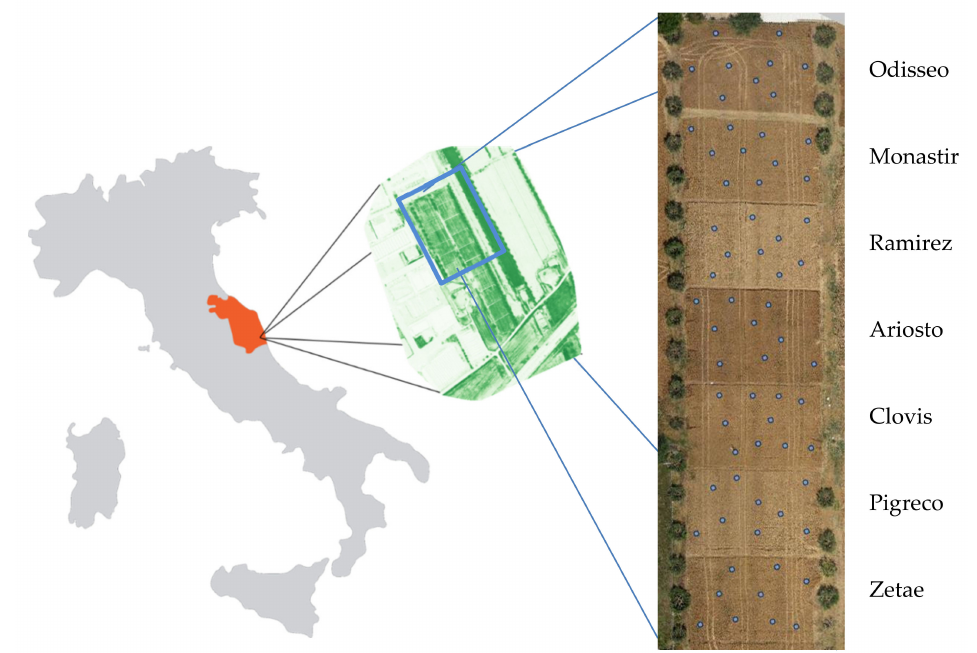
Figure 1. Left image: Study area (NDVI image). Middle image: Durum wheat cultivars (RGB image at harvest). Right image: Sixty-five georeferenced ground truth areas collected at